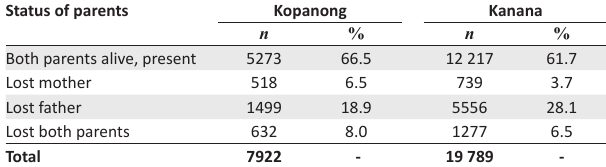
TABLE 2: Status of parents of children in the